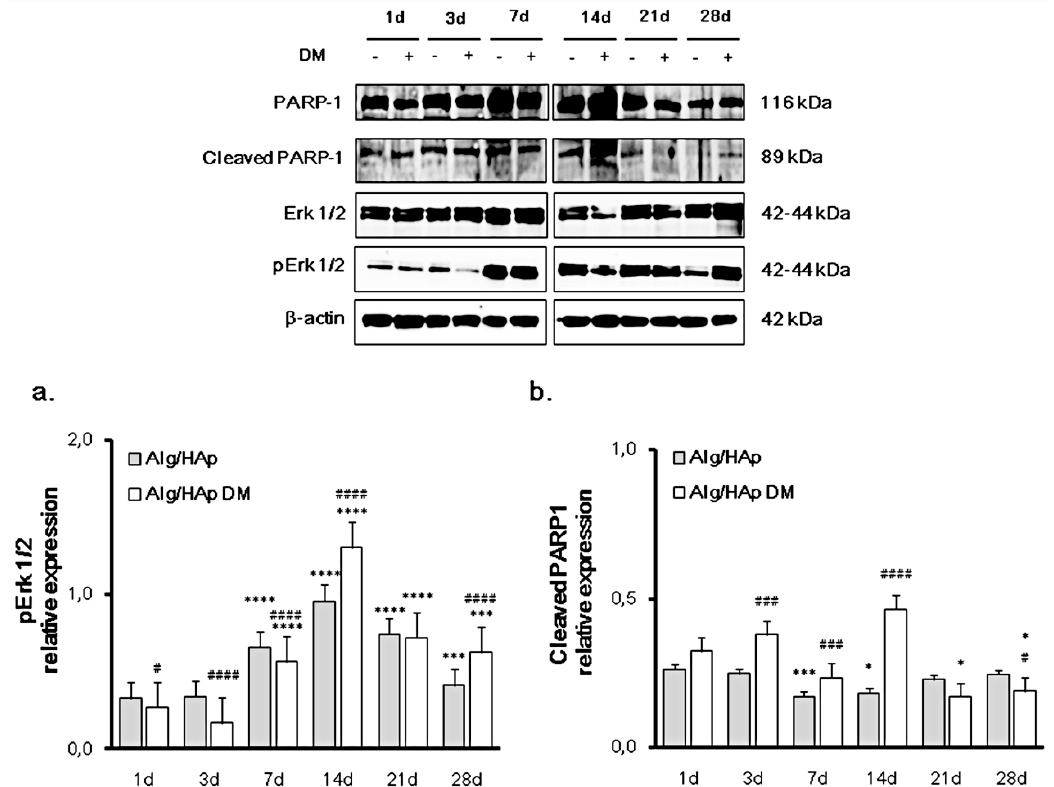
Figure 2. Extracellular signal-regulated kinases (Erk 1 / 2) phosphorylation and cleavage of Poly [ADP-ribose] polymerase-1 (PARP-1) and in DPSCs growth onto Alg / HAp sca ff olds. Typical results of Erk 1 / 2 and PARP-1 protein expression by Western blotting of three independent experiments. β -actin was used as a protein content marker. The bar graphs show densitometric values expressed as the mean percentage ± SEM ( n = 3) of integrated optical densities of protein bands normalized on β -actin. ( a ) *** p < 0.005 between Alg / HAp at 28 days with or without DM and Alg / HAp at one day; **** p < 0.0005 between Alg / HAp at seven, 14, and 21 days with or without DM and Alg / HAp at one day; # p < 0.05 between Alg / HAp with and without DM at one day; #### p < 0.0005 between Alg / HAp with and without DM at three, seven, 14, and 28 days. ( b ) * p < 0.05 between Alg / HAp at 14 days and Alg / HAp at one day; * p < 0.05 between Alg / HAp with DM at 21 and 28 days and Alg / HAp at one day; *** p < 0.005 between Alg / HAp at seven days and Alg / HAp at one day; # p < 0.05 between Alg / HAp with and without DM at 28 days; ### p < 0.005 between Alg / HAp with and without DM at three and seven days; #### p < 0.001 between Alg / HAp with and without DM at 14 days.